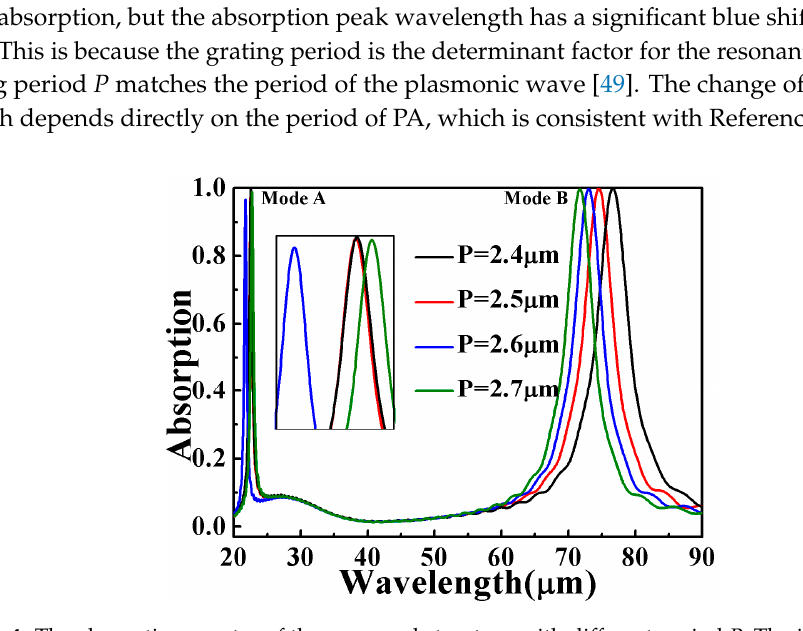
Figure 4. The absorption spectra of the proposed structure with different period P . The insert graph is the absorption peak of Mode A. the absorption peak of Mode